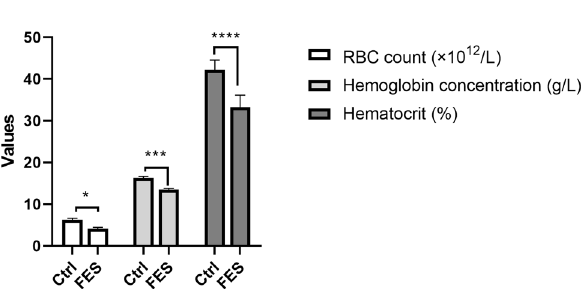
Figure 3. The effects of FES on RBC, hemoglobin and hematocrit. All data are presented as mean ± SD (n = 12). * P < 0.05 versus control group, *** P < 0.005 vs. control group, **** P < 0.001 versus control